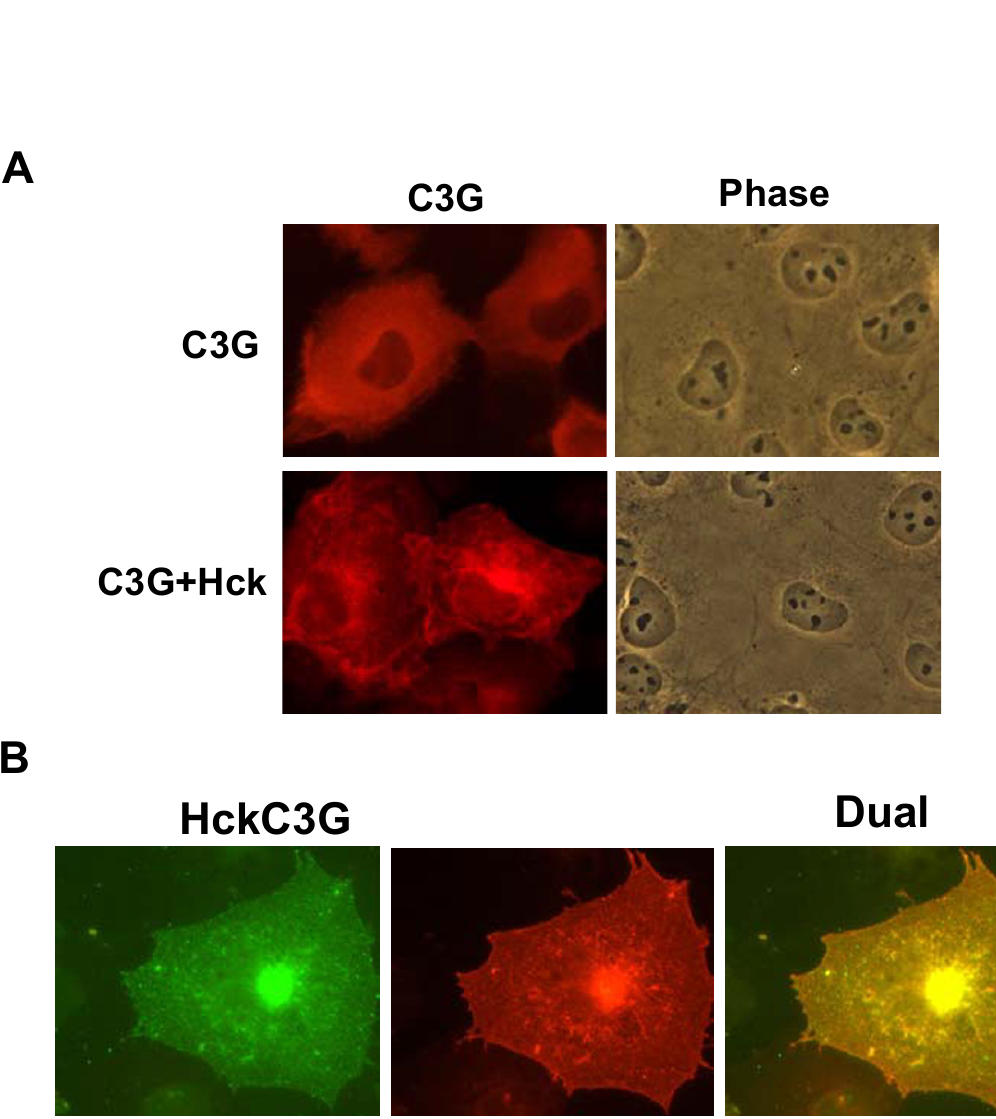
Figure 1 Subcellular localization of C3G. (A) Cos-1 cells grown on coverslip were either transfected with C3G or cotransfected with Hck and indirect immunofluorescence staining performed using anti-C3G antibodies and Cy3 conjugated anti rabbit sec- ondaries. (B) Cells transfected with Hck and C3G were stained for both the antigens as described in Materials and Methods. Hck was visualized using FITC conjugated secondaries and C3G by Cy3 conjugated secondaries. The dual panel shows the merged image of an optical section taken using the confocal microscope where the yellow signal generated shows colocaliza- tion of the two